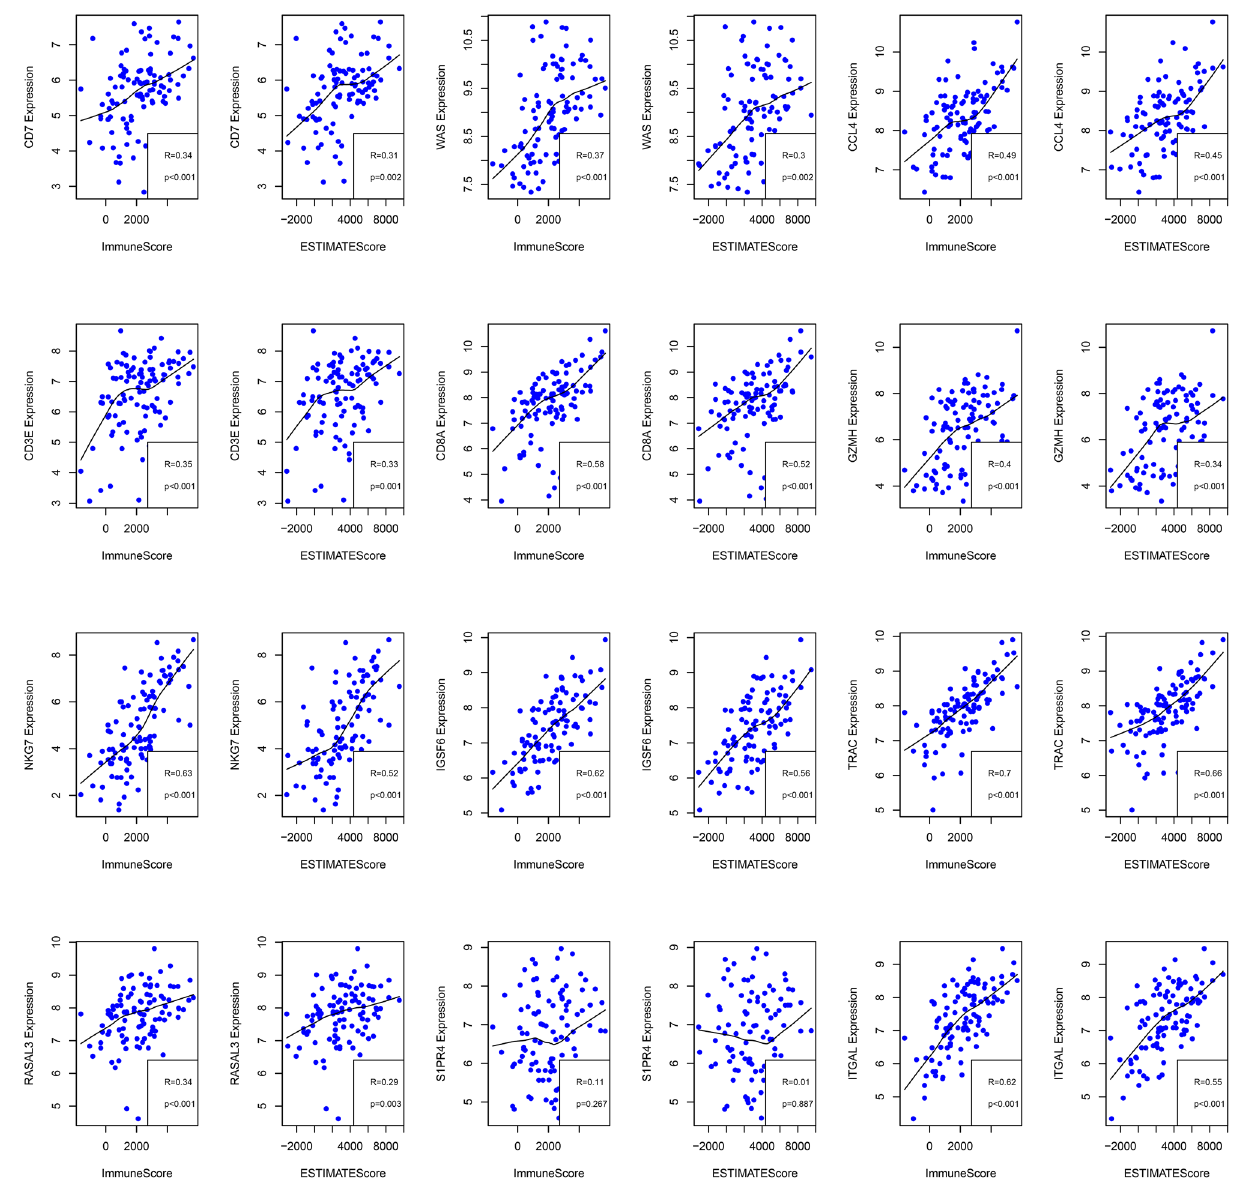
Figure 11. Correlations between 12 immune-related prognostic genes and ImmuneScore/ESTIMATEScore within GSE17025